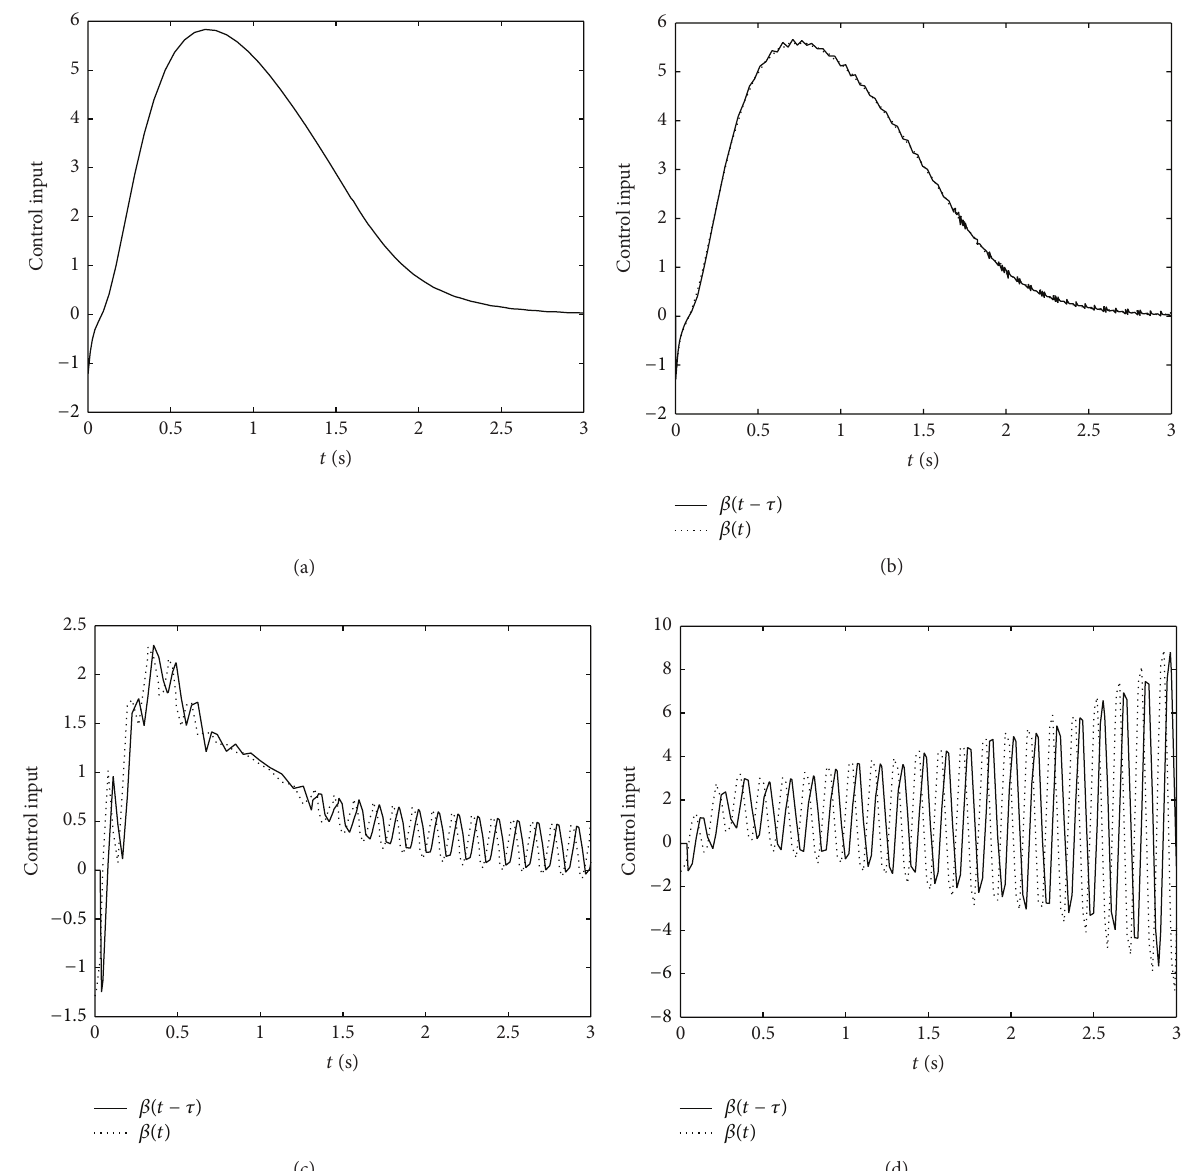
Figure 7: Time histories of control input at 𝑈 = 10 m/s and (a) 𝜏 = 0 s; (b) 𝜏 = 0.001 s; (c) 𝜏 = 0.032 s; (d) 𝜏 = 0.041 s.